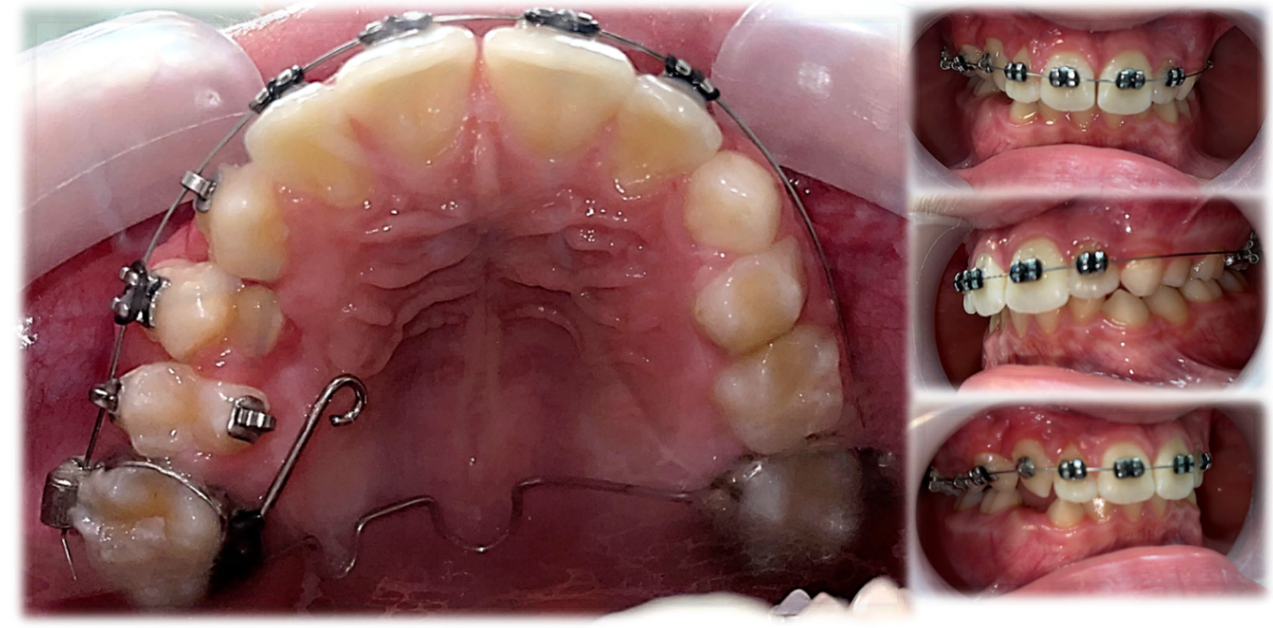
Figure 12. Upper occlusal photograph 9 months after surgery ( a ) and during orthodontic treatment ( b ).